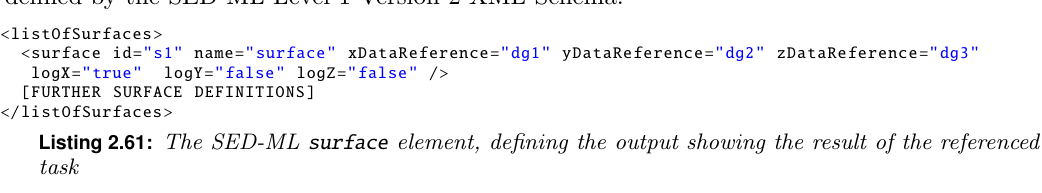
as defined by the SED-ML Level 1 Version 2 XML